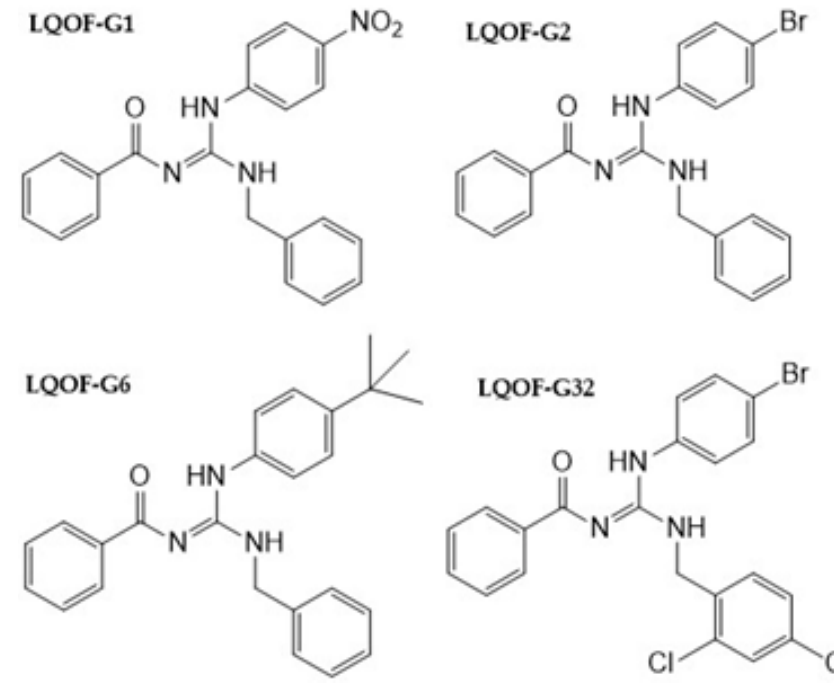
Figure 2. Structures of investigated